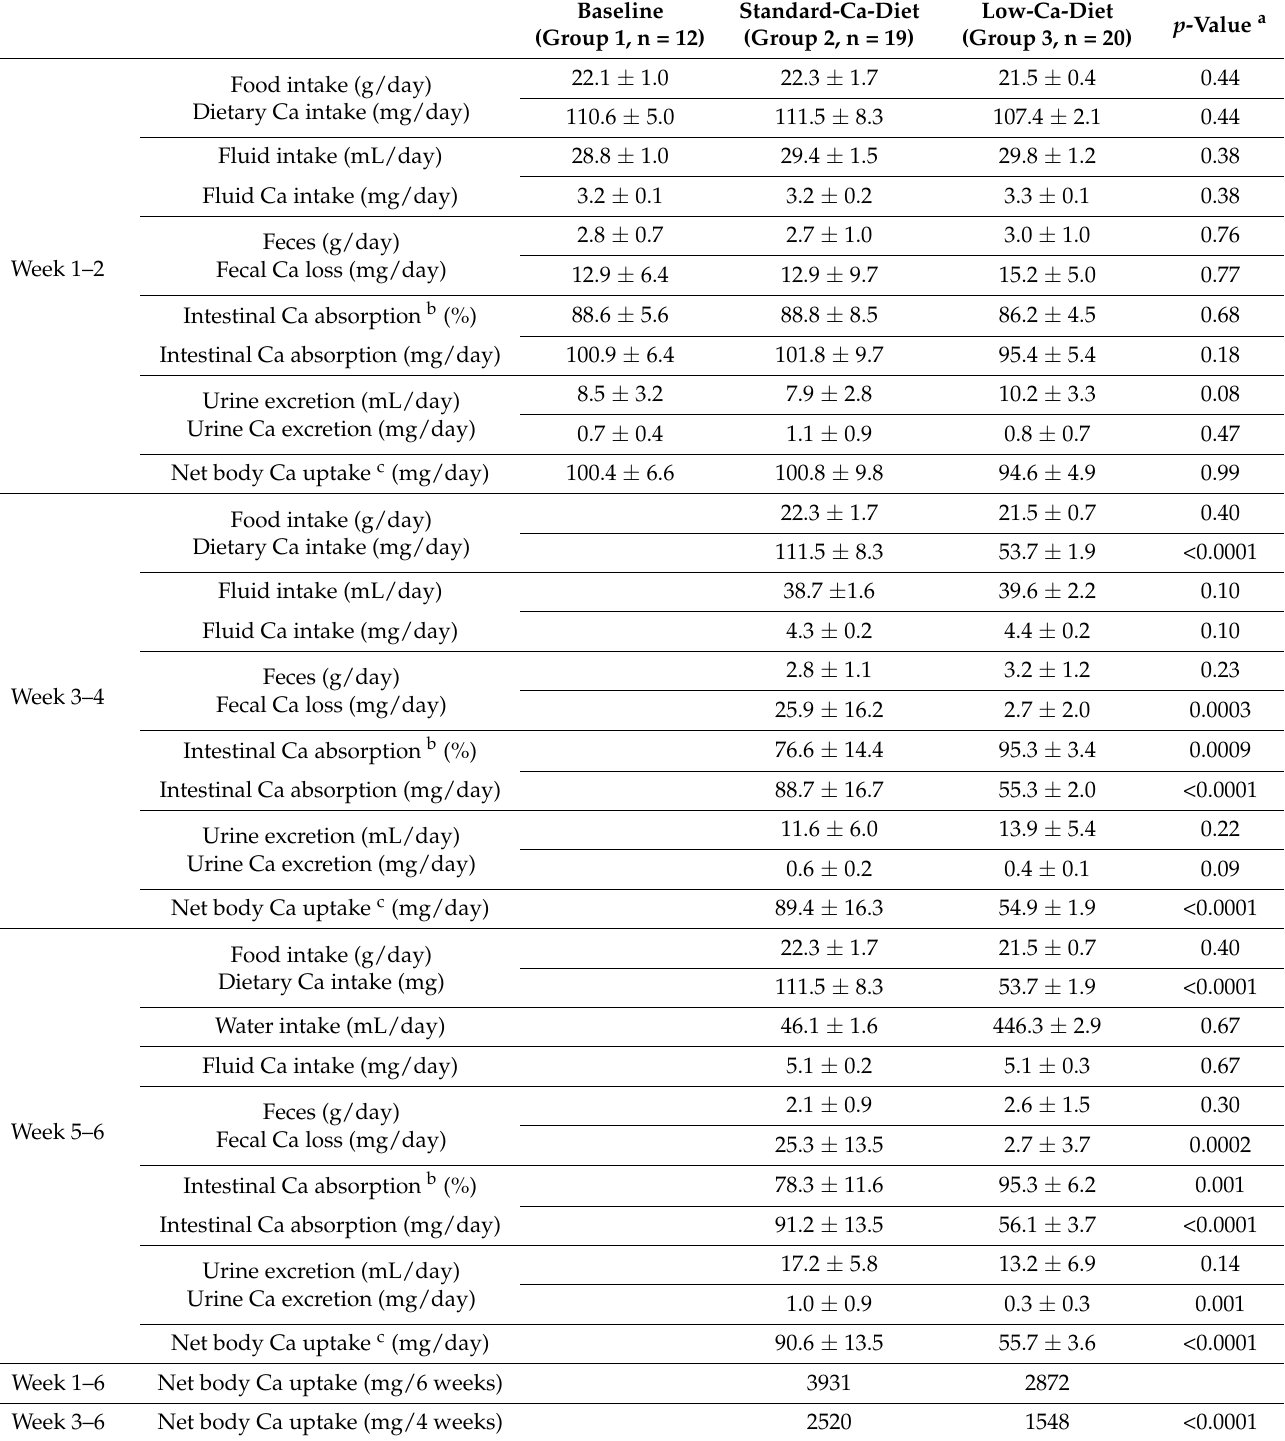
Table 1. Ca balances measured during two weeks of standard-diet (group 1, 0.5% Ca) followed